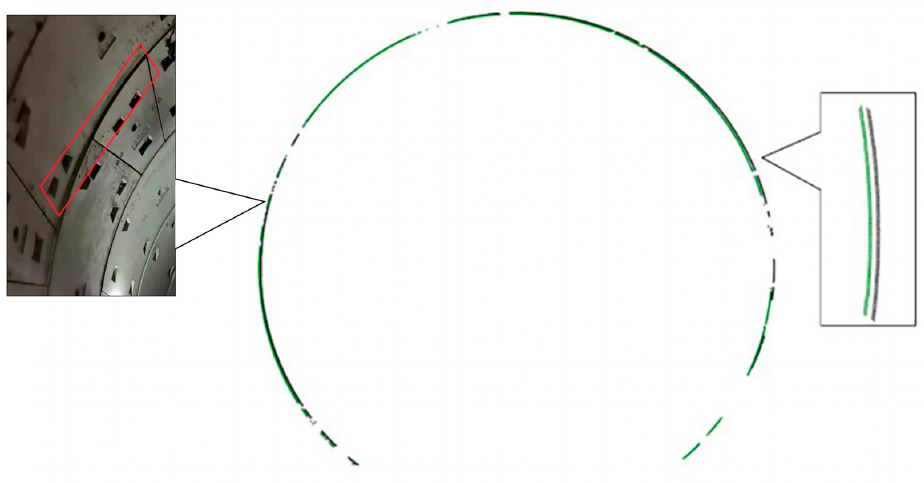
Figure 10. Sectional superposition results.